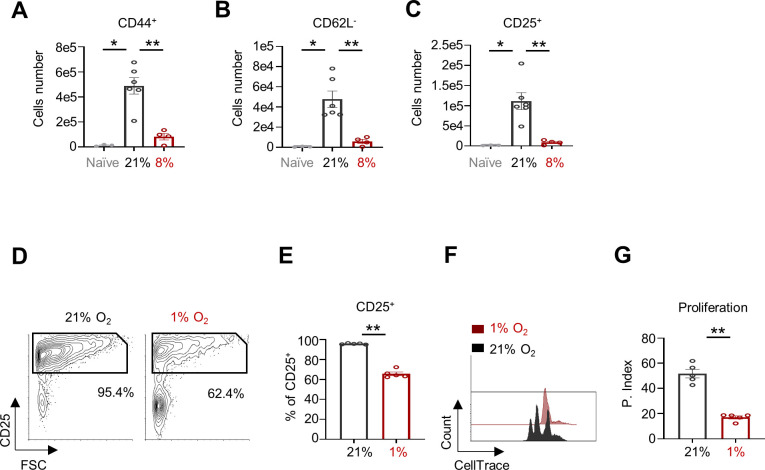
Systemic chronic oxygen restriction inhibits CD8+ T cell activation and response.(A–C) C57BL6 mice were primed intradermally in the ear pinna with 5 × 106 TU of Lv-OVA or left untreated. Twenty-four hours following the viral challenge, mice were transferred to chambers and maintained under 8% or 21% oxygen pressure. Cells from the deep cervical lymph nodes were then extracted and analyzed by flow cytometric analysis. (naïve group n = 3, activated n = 6 in each group) (A) Bar graph of the numbers of TCR Vα2+, CD8+ and CD44+ cells from naïve mice (gray) or Lv-OVA challenged mice that were kept under 21% oxygen (black) or 8% oxygen (red). (P value * 0.0238, ** 0.0095) (B) Bar graph of the numbers of TCR Vα2+, CD8+ and CD62L- cells from naïve mice (gray) or Lv-OVA challenged mice that were kept under 21% oxygen (black) or 8% oxygen (red). (P value * 0.0238, ** 0.0095) (C) Bar graph of the numbers of TCR Vα2+, CD8+ and CD25+ cells from naïve mice (gray) or Lv-OVA challenged mice that were kept under 21% oxygen (black) or 8% oxygen (red). (P value * 0.0238, ** 0.0095) (D-G) CellTrace-labeled PBMCs from human donors were activated with anti-CD3/28 for 72 hr under either 1% or 21% of oxygen pressure. (D) Representative flow cytometry plots of FSC vs. CD25 gated on CD8+ T cells. Numbers indicate the frequencies of CD25+ cells. (E) Bar graph summarizing the results in D. (P value ** 0.0079) (F) Representative Flow cytometry overlay histogram of CellTrace intensity gated on CD8+ T cells. (G) Bar graph summarizing the results in F as Proliferation Index (P. Index). (P value ** 0.0079). Statistical method, non-parametric Mann-Whitney test, mean ± s.e.m.